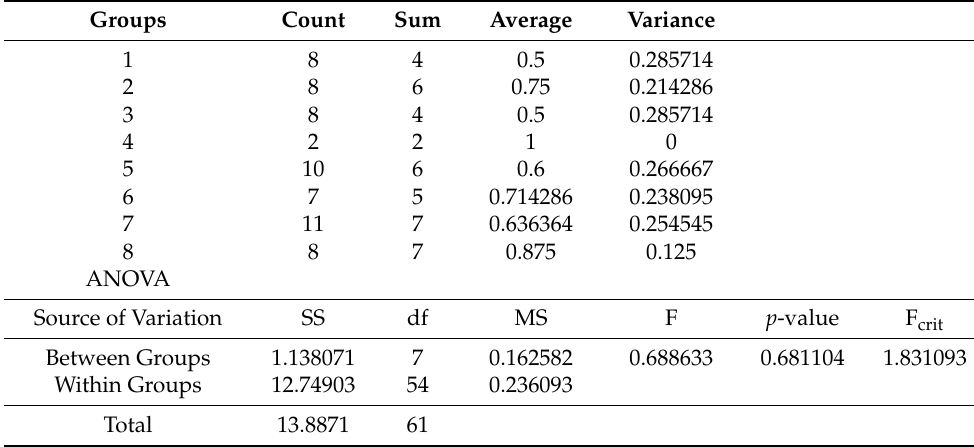
Table 4. Results from the ANOVA on users’ accuracies with alpha = 0.1.